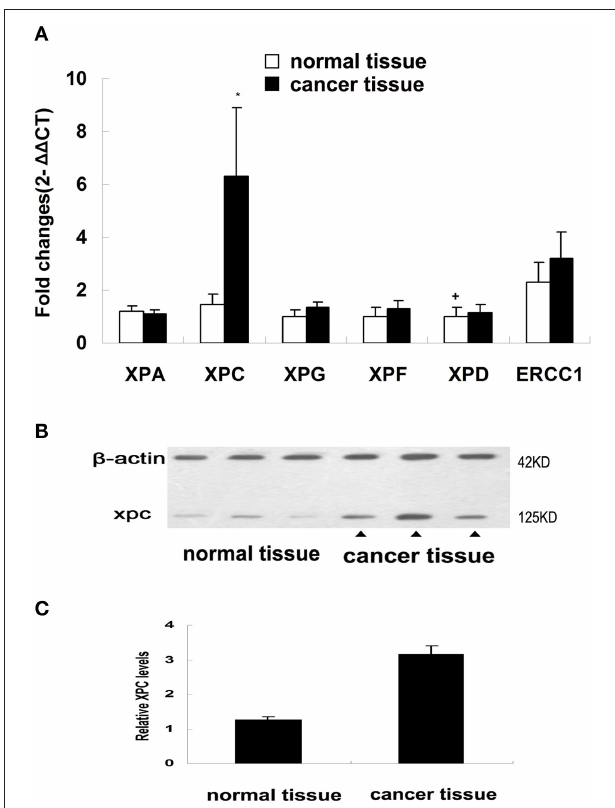
FIGURE 1 | NER genes mRNA expression and XPC protein expression in normal colorectal tissue and colorectal tumor tissue. (A) NER gene transcripts in colorectal tumor tissues detected by real-time PCR. Changes were normalized against GAPDH, and all genes were compared with XPD (The mark of ‘ + ’ representing the expression of XPD in normal colorectal tissue as baseline). * P < 0.01 compared with the normal colorectal tissues. (B) XPC protein expression by western blot in colorectal tumor tissue and normal colorectal tissue of four patients. (C) XPC protein relative amounts in colorectal tumor tissue and normal colorectal